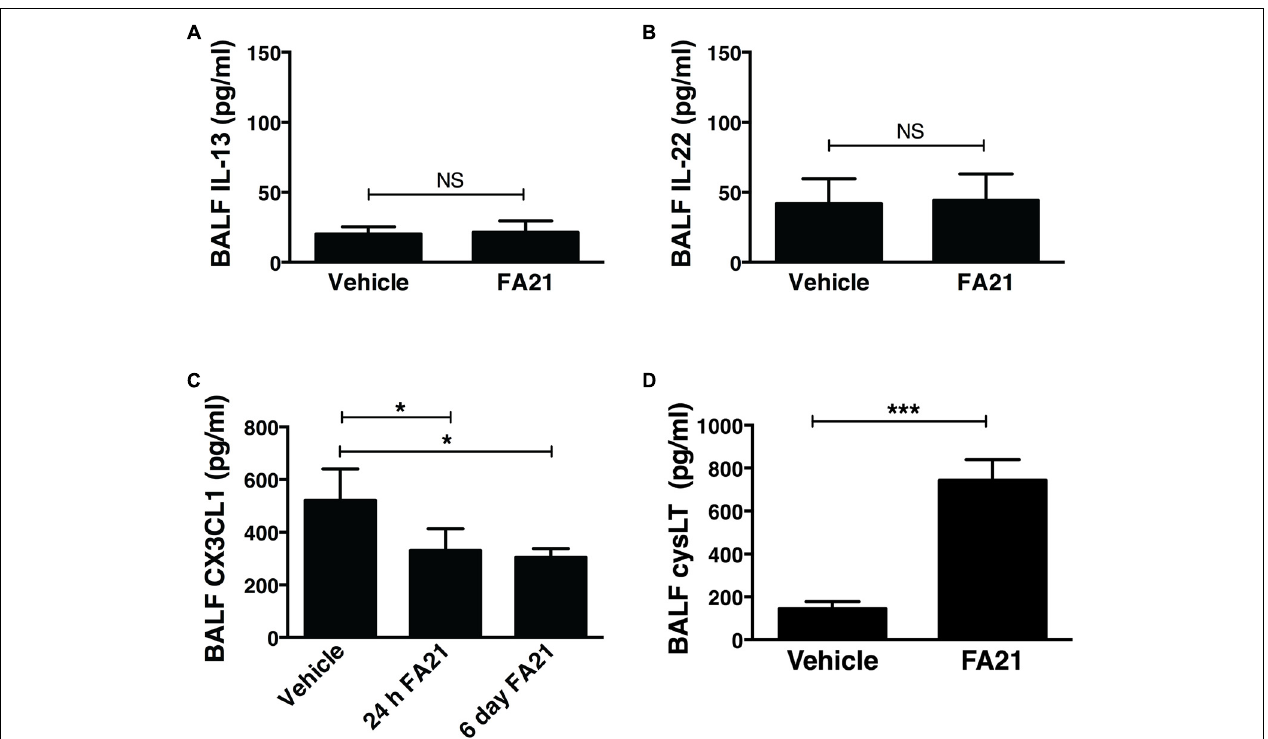
FIGURE 3 | Intratracheal administration of high nickel MWCNT resulted in the biosynthesis of cysLT in the absence of T cell-associated cytokines. C57BL/6 mice (six per group) were exposed to FA21 MWCNT (50 µ g) or dispersion medium (vehicle alone) by oropharyngeal instillation. BALF was collected 24 h after exposure and the levels of IL-13 (A) , IL-22 (B) , CX 3 CL1 (C) , and cysLT (D) determined by ELISA. Results are mean ± SEM ( n = 6), ∗ p < 0.05 and ∗∗∗ p < 0.001 (NS = not significant). Data are representative of 3–4 independent